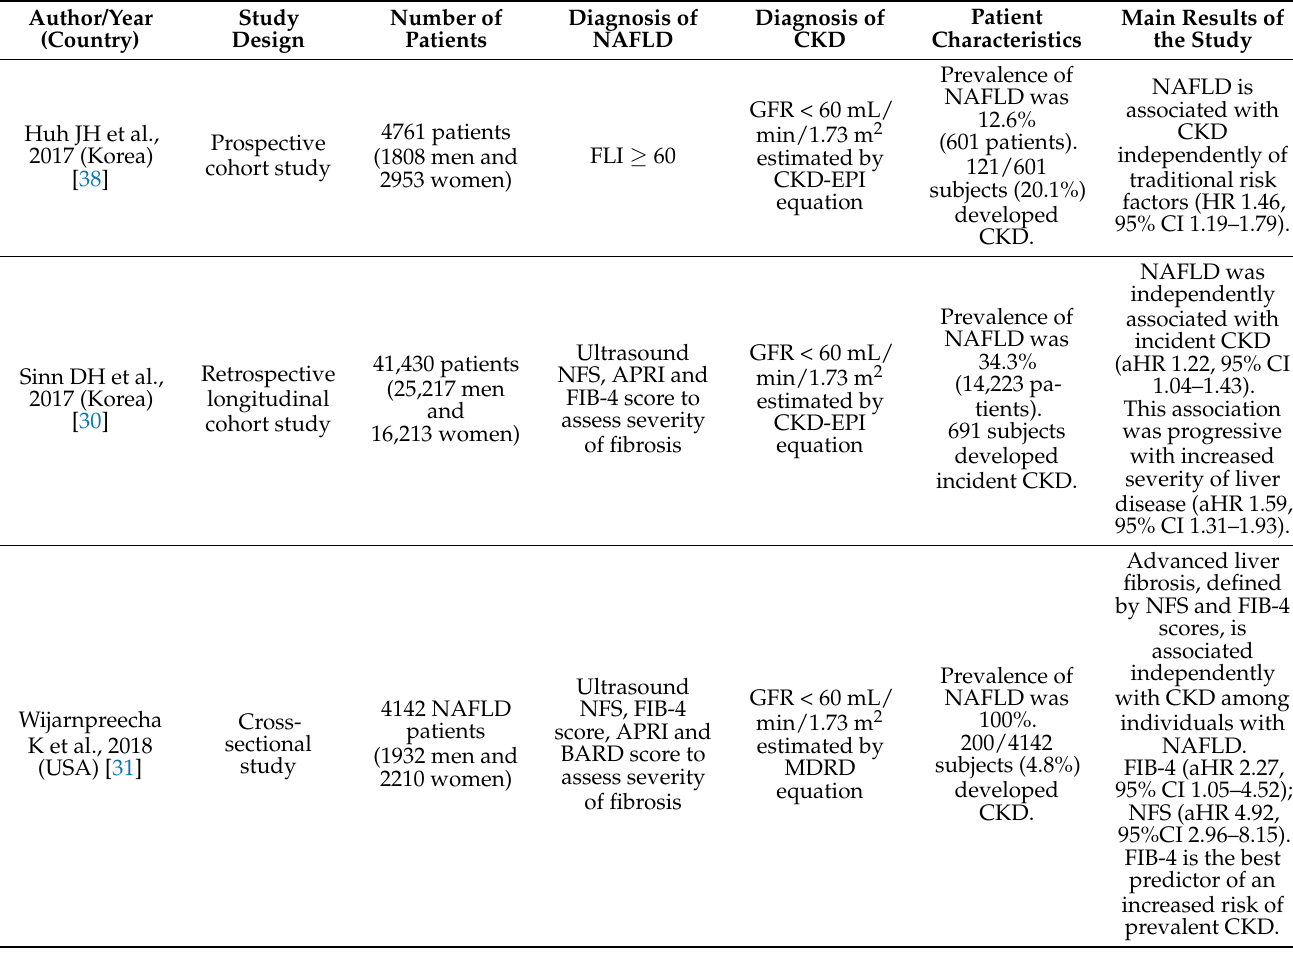
Table 1. Summary of the 12 relevant studies considered in the